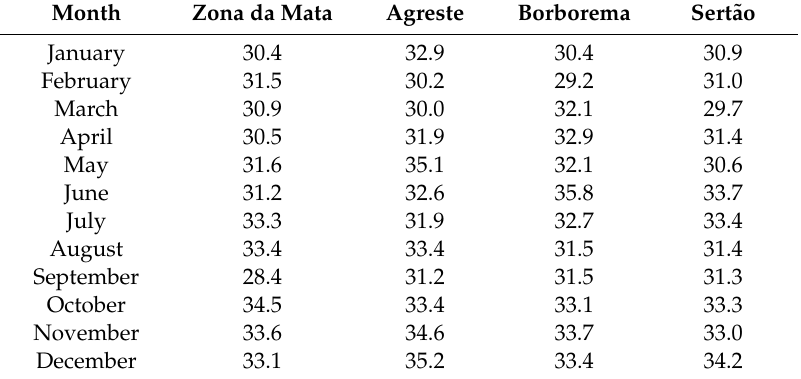
Table 4. Mean values of RMSE of rainfall (mm) for 1994–2014 in the mesoregions of Zona da Mata, Agreste, Borborema, and Sert ã o.